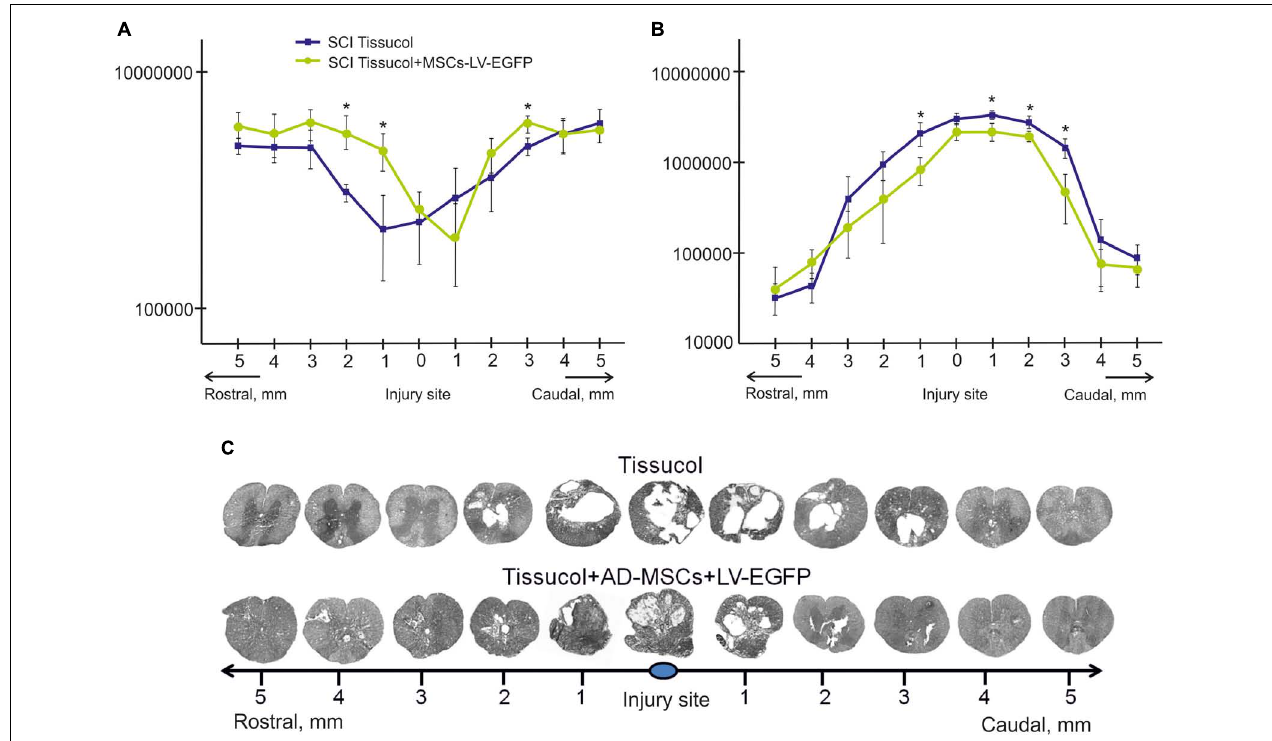
FIGURE 2 | Tissue analysis in control and experimental groups. An area of the spared tissue (A) and a total area of abnormal cavities (B) 5 mm rostrally and caudally from the injury epicenter in 60 days after Tissucol (blue line) or Tissucol+AD-MSCs+LV-EGFP (yellow line) application. ∗ P < 0.05, one-way ANOVA followed by a Tukey’s post hoc test. Cross-sections of the injured spinal cord 60 days after Tissucol or Tissucol+AD-MSCs+LV-EGFP application 5 mm rostrally and caudally from the injury epicenter (C) . Azur-eosin